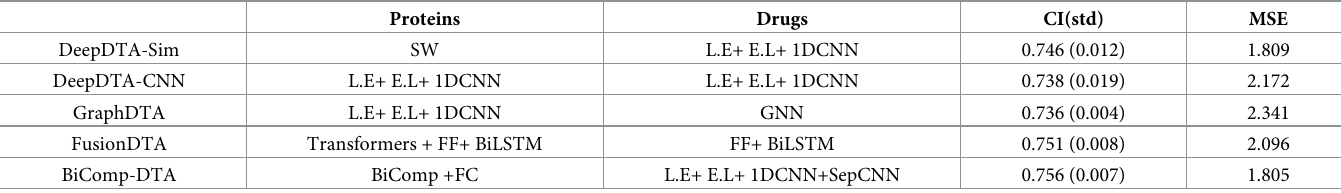
Table 7. The CI and MSE values for the BiComp-DTA, compared to the alternative methods, assuming protein family splitting setting- PDBbind dataset. Proteins